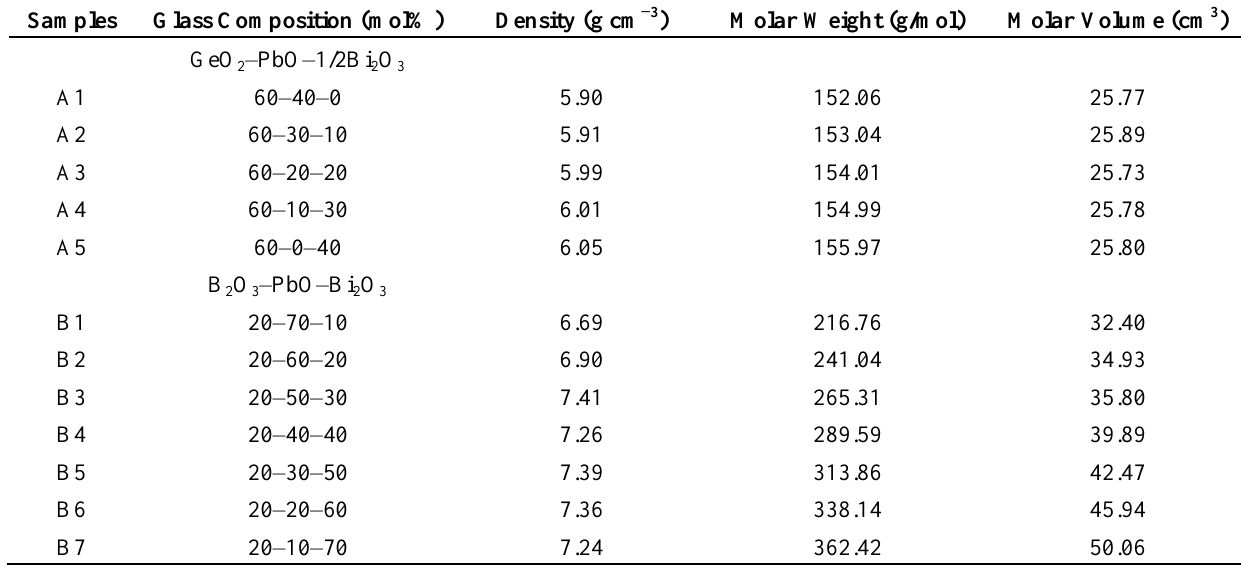
Table 1. Glass composition of the ternary lead-bismuth germanate glasses of the form